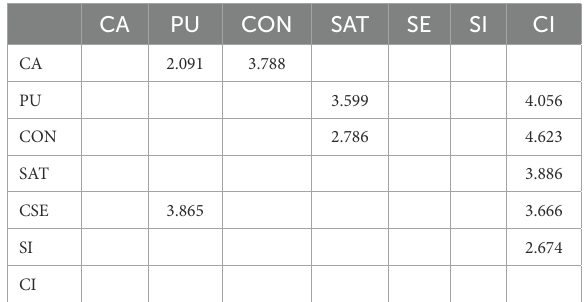
TABLE 6 Collinearity test.